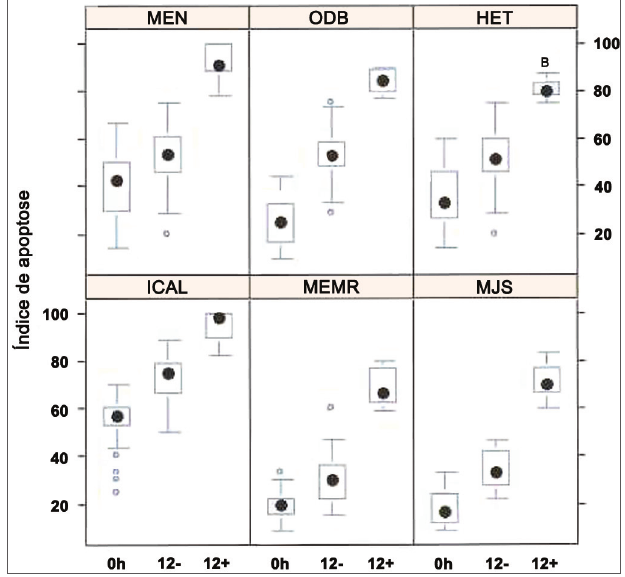
Figura 6. Índice apoptótico (n = 6 pacientes) avaliados através da reação de TUNEL. Teste de Kruskall Wallis: p < 0,001 para todos os